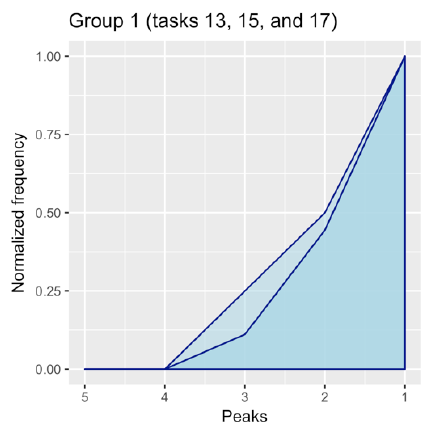
Fig. 8. Group of tasks with fastest learning curves. Tasks 13, 15, and 17 are, respecivelly: View a comment; Create a heuristic evaluation; View the "about page". This group sums up to 35 observations.